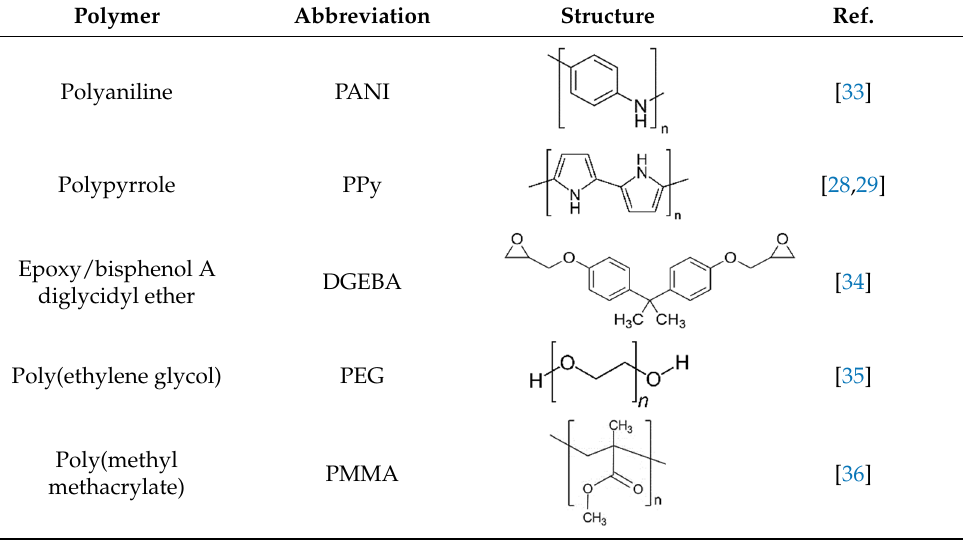
Table 1. Examples of polymers for corrosion defense.